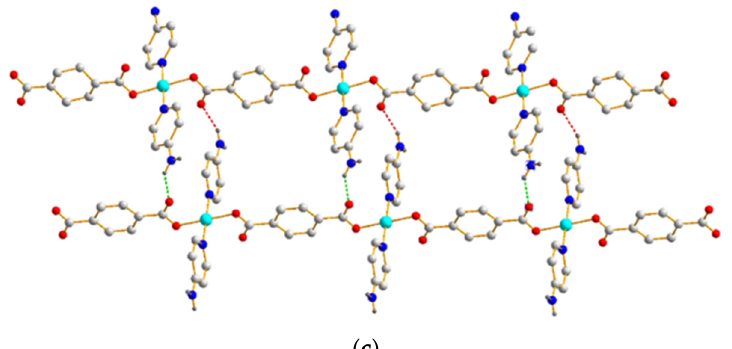
Figure 5. ( a ) Coordination environments about the two independent Cu(II) ions in 5a . Symmetry transformations used to generate equivalent atoms: (A) 1 − x, 1 − y, − z; (B) 2 – x, − y, 1 – z. ( b ) The Cu(II) ions are linked by 1,4-BDC 2 − ligands to form 1D linear chains. ( c ) A diagram showing the N-H—O interactions.